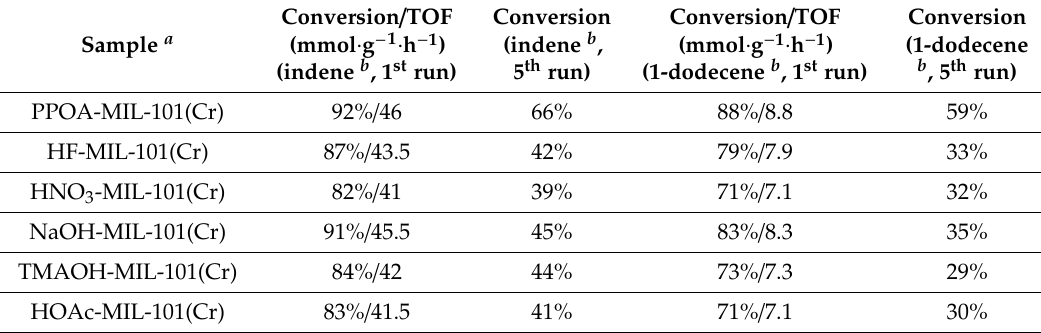
Table 2. The conversion of indene and 1-dodecene by MIL-101(Cr) with di ff erent modulators.